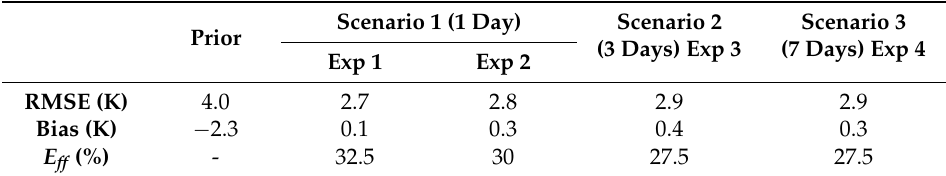
Table 3. GPS downscaling results averaged over the whole region and for the 23 considered validation dates, compared to SETHYS prior estimations.